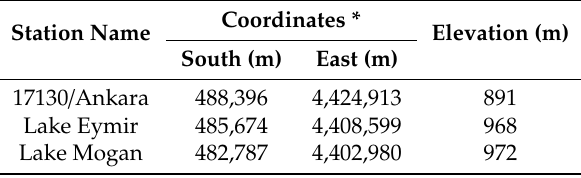
Table 1. Location information of observation stations.